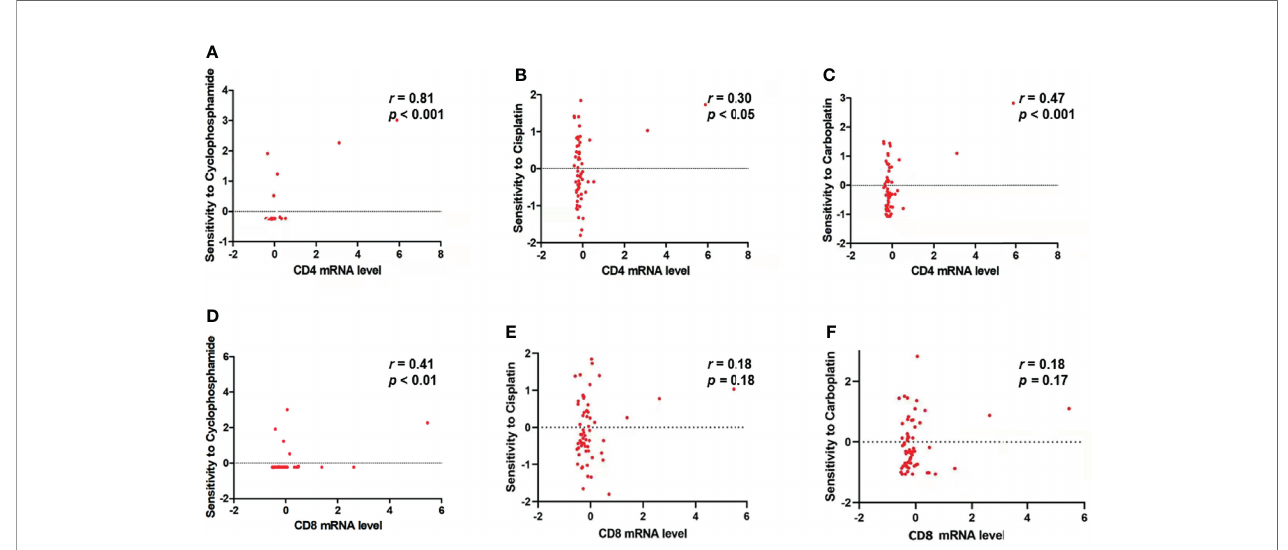
FIGURE 7 | CD4 mRNA and CD8 mRNA expression level is related to the sensitivity of tumor cells to NAC drugs. (A – C) CD4 mRNA expression level is signi fi cantly and positively correlated with the sensitivity of tumor cells to (A) cyclophosphamide ( r = 0.81, p < 0.0001), (B) cisplatin ( r = 0.30, p < 0.05), and (C) carboplatin ( r = 0.47, p < 0.001). (D) CD8 mRNA expression level is signi fi cantly and positively correlated with the sensitivity of tumor cells to cyclophosphamide ( r = 0.41, p < 0.01). (E, F) CD8 mRNA expression level is not signi fi cantly correlated with the sensitivity of tumor cells to (E) cisplatin ( r = 0.18, p = 0.18) and (F) carboplatin ( r = 0.18, p =